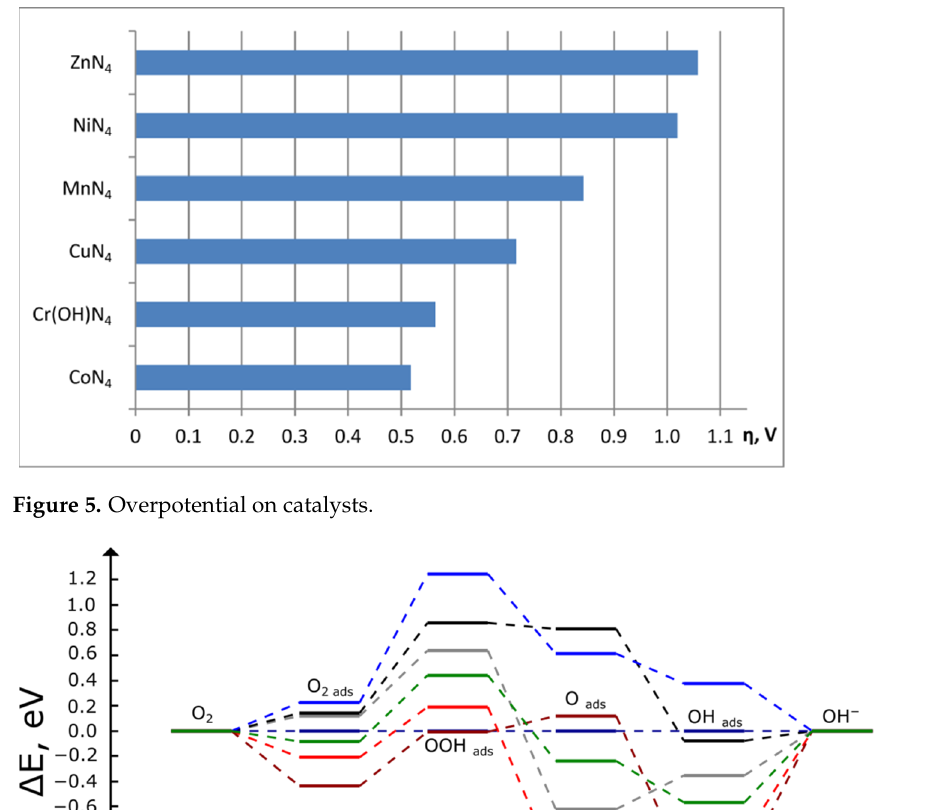
Figure 6. Free energy profile of ORR on the studied catalysts with a voltage of 1.20 V. CoN—grey; CuN 4 —black; NiN 4 —blue; MnN 4 —red; ZnN 4 —dark red; Cr(OH)N 4 —green. The ideal catalyst— dark blue.